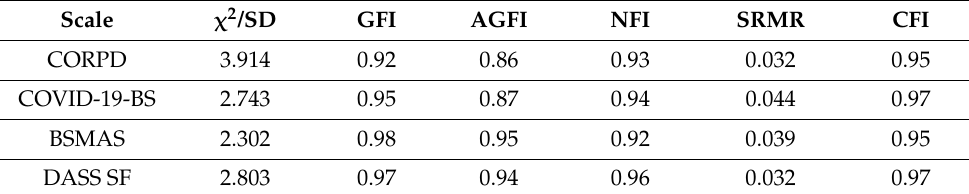
Table 6. Confirmatory factor analysis results of the scales.